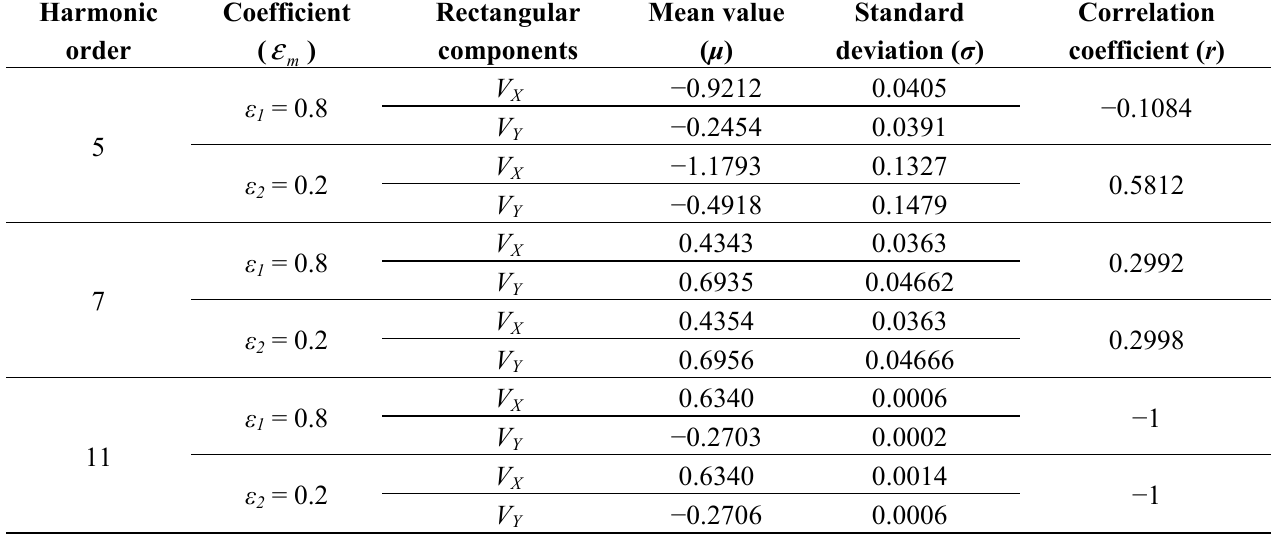
Table 9. Statistical characteristic of harmonic voltage at bus